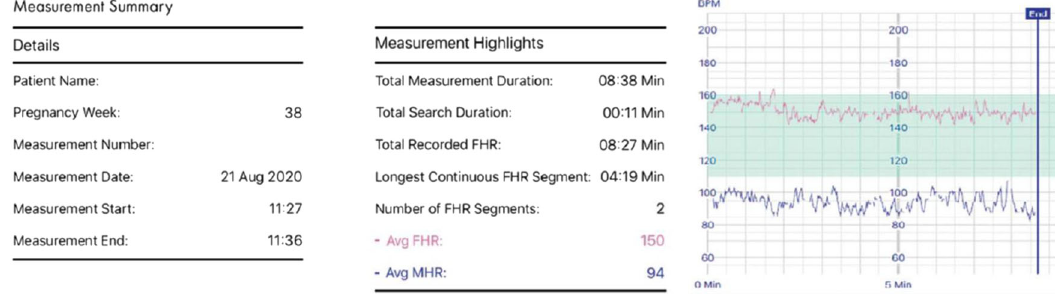
Fig. 6 Sample data output from the fetal heart rate (FHR) monitoring system. MHR, maternal heart